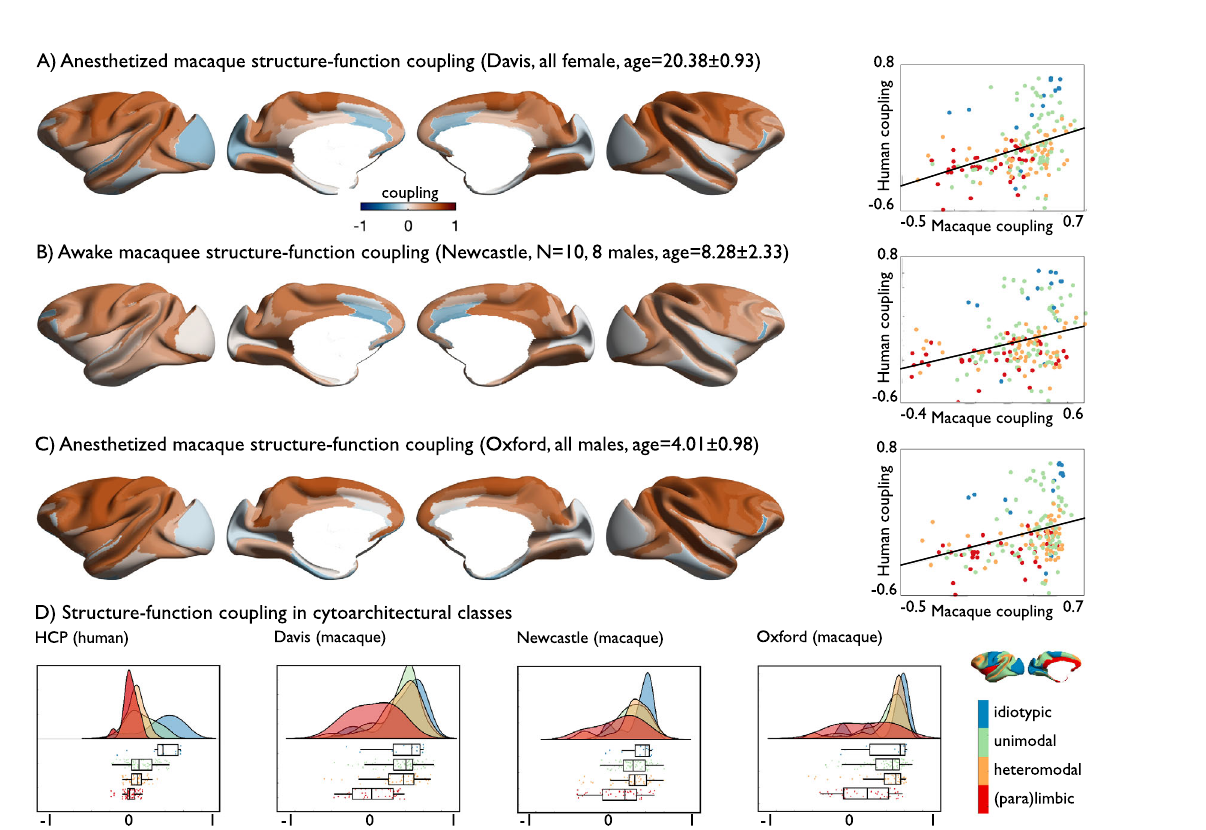
Fig. 4 Structure – function coupling in different macaque samples. A Anesthetized macaque (sample: Davis) structure – function coupling and correlation with human structure – function coupling projected to macaque space; B Awake macaque (sample Newcastle) structure – function coupling and correlation with human structure – function coupling projected to macaque space; C Anesthetized macaque (sample Oxford) structure – function coupling and correlation with human structure – function coupling projected to macaque space; D Structure – function coupling averaged in cytoarchitectural classes 59 across 182 parcels of the Markov parcellation for HCP, Davis, Newcastle and Oxford samples, boxes show the median and interquartile (25 – 75%) range, whiskers depict the 1.5*IQR from the quartile. Source data are provided as a Source Data fi le. Table 2 Difference in structure – function coupling between humans and macaque across